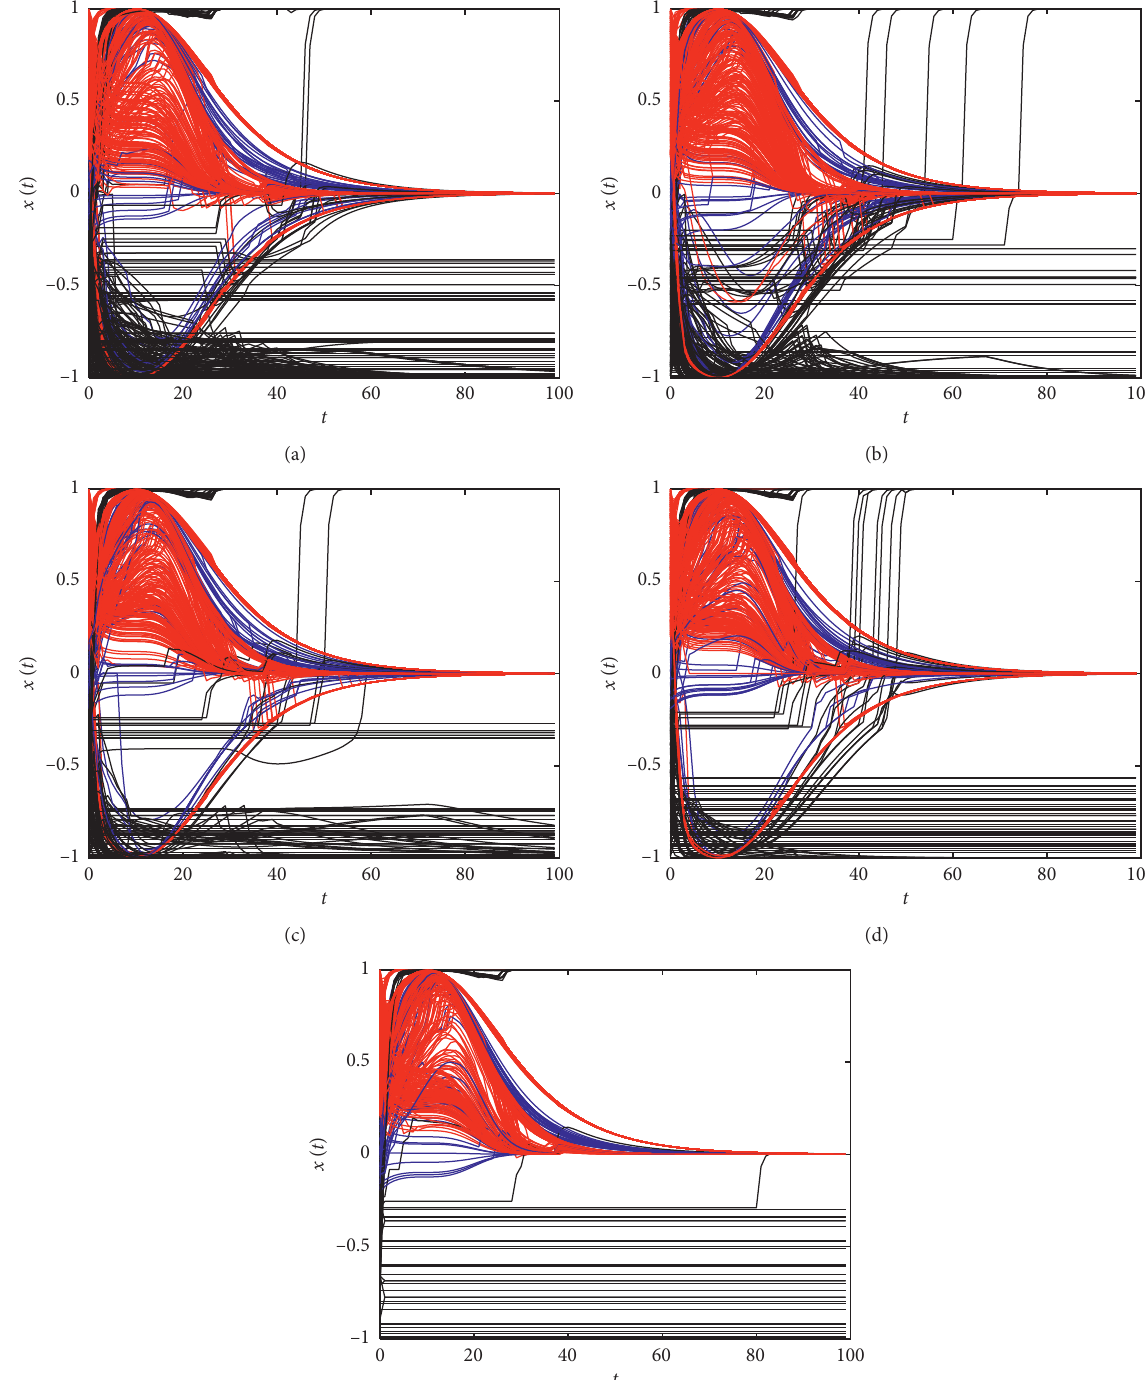
Figure 8: Impact of the proportion of group opinions’ tendency on individual opinion reversal: (a) P (b) P s � 60%, P o � 35%, and P n � 5%; (c) P s � 70%, P o � 25%, and P n � 5%; (d) P s � 80%, P o � 15%, and P n � 5%; (e) P s � 90%, P o � 5%, and P n �